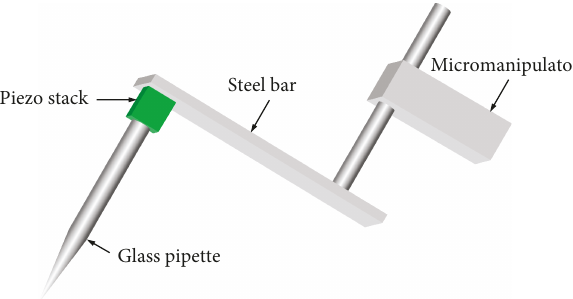
Figure 2: Construction of the piezo stimulator. Glass pipette with melted tip was glued on a piezo stack and then on a steel bar, which was fi xed on a